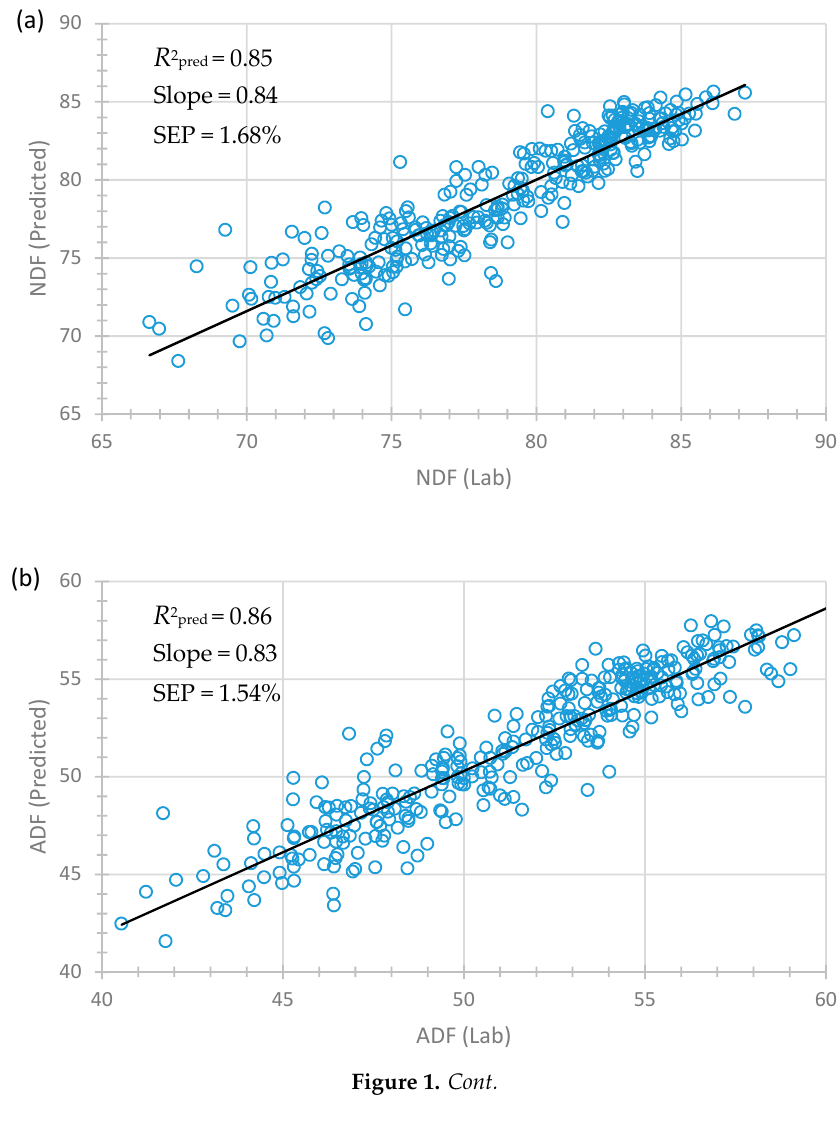
Figure 1. Linear regression relationship (includes R 2 pred , slope, and SEP) of laboratory reference data and NIRS predicted values from the first validation set for ( a ) neutral detergent fiber (NDF), ( b ) acid detergent fiber (ADF), ( c ) acid detergent lignin (ADL), ( d ) cellulose, ( e ) hemicellulose, ( f ) carbon, and ( g ) nitrogen using the